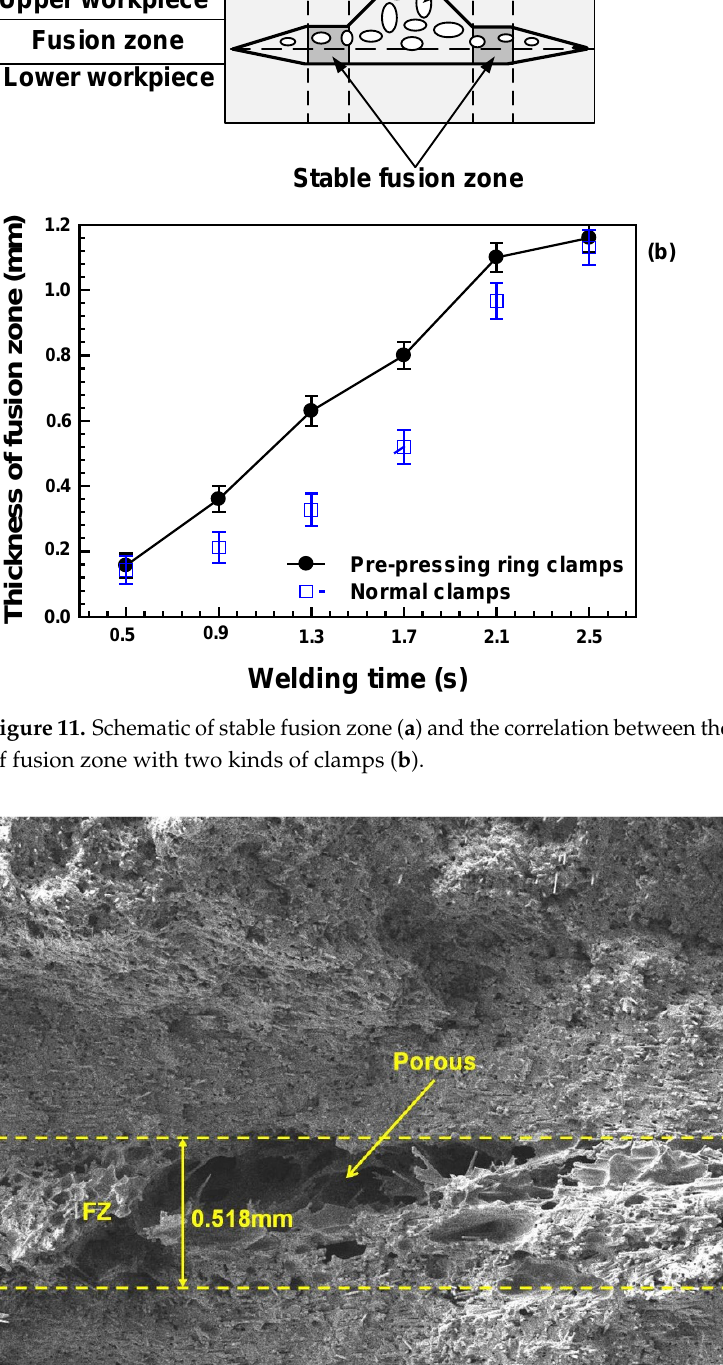
Welding time (s) Central nugget of PPRCUW Central nugget of NUW Perimeter nugget of PPRCUW Perimeter nugget of NUW Figure 10. Effects of welding time on weld nugget size of NUW and PPRCUW joints. Careful examinations of the fractured faying surfaces showed that there existed a small porous region for the weld made with PPRC and 2.1 s weld time (Figure 8e). While the faying surface was relatively compact with a 2.1 s weld time (Figure 9e) and porous region occurred when the weld time was longer than 2.5 s for normal clamp. These char- acteristics suggested that the temperature in the weld made with 2.1 s was high and re- sulted in the decomposition of Nylon 6 matrix for PPRC. The results were consistent with the recorded transient temperature history shown in Figure 7. The aforementioned anal- yses indicated that the PPRC enhanced the energy transmission efficiency of the central of overlap during ultrasonic welding. 3.5. Effect of Clamp on Weld Microstructure Literature showed that welding quality was closely correlated with the weld micro- structure [21,22]. The thickness of fusion zone can significantly influence the joint strength [29,30]. Hence, the effect of clamp on weld microstructure was investigated. Figure 11a,b show the schematic of stable fusion zone at the weld zone and the correlation between the weld time and thickness of the fusion zone with two kinds of clamps. Referring to Figure 11, the thickness of the fusion zone for UW joints made with the PPRC was greater than